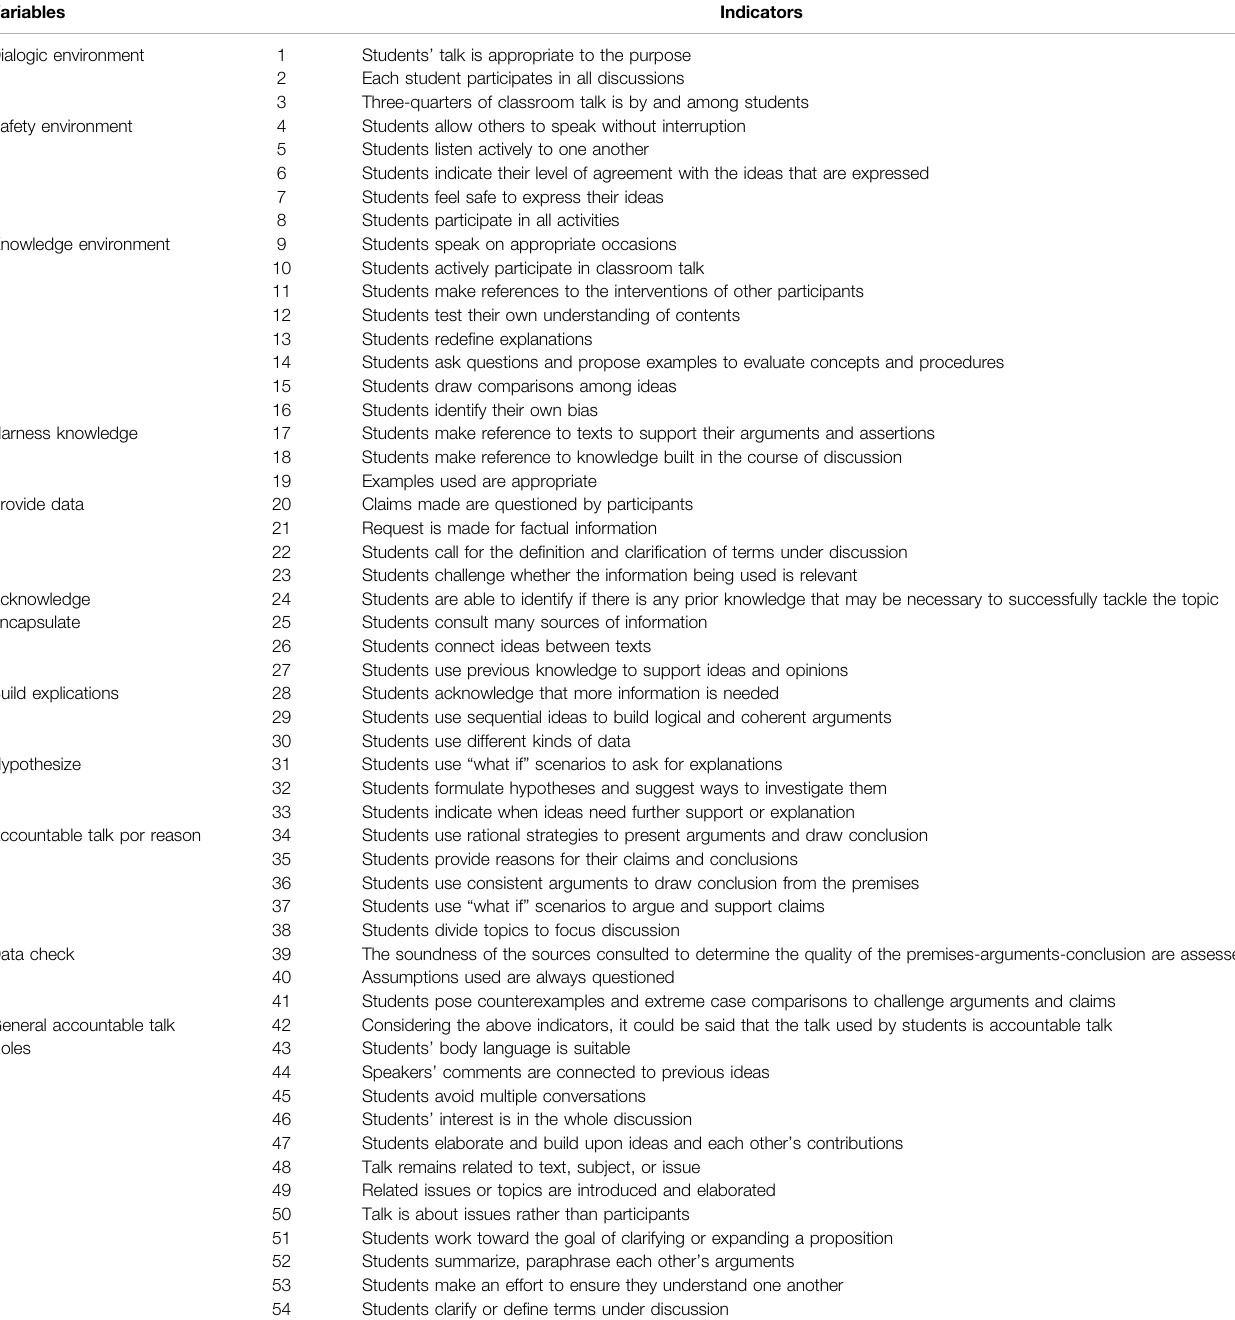
TABLE 2 | Behavioral